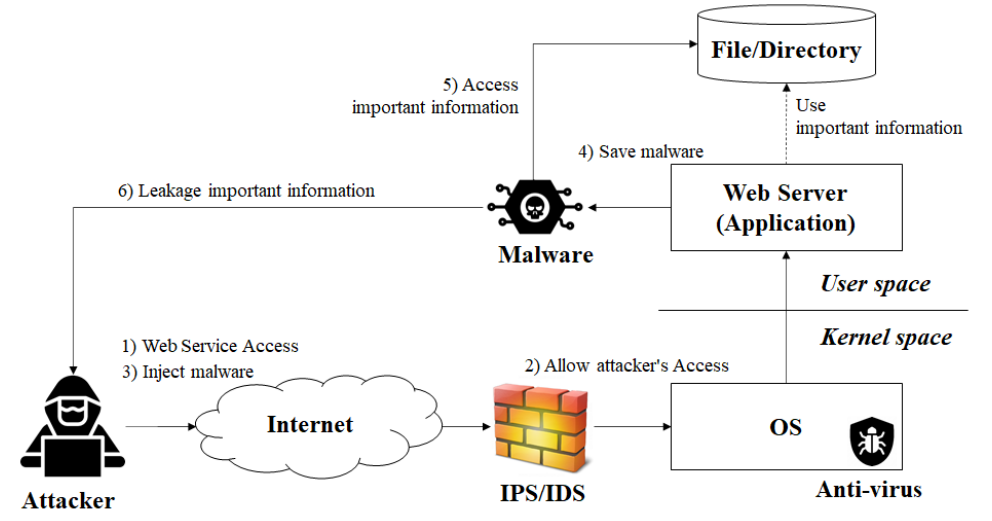
Figure 2. Multi-layered security